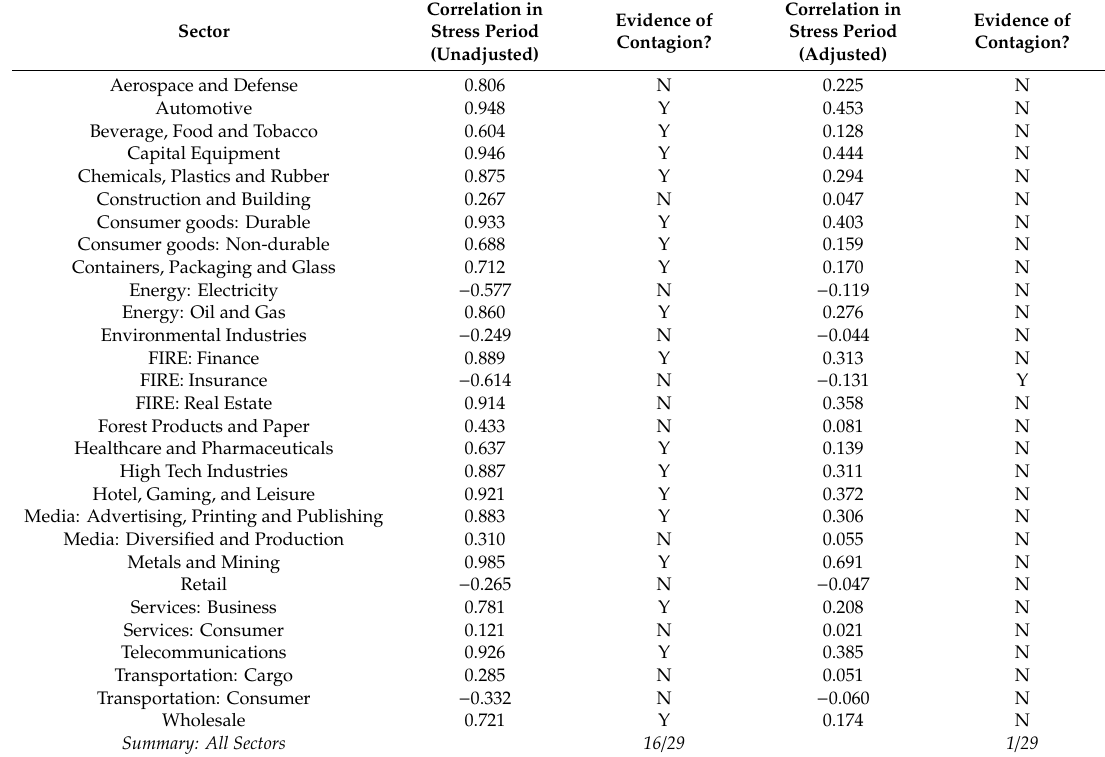
Table 1. Biased and adjusted correlation coefficients for contagion tests in August 2007. Source: Author’s calculations. Note: Contagion tests based on statistical tests for differences in correlation coefficients calculated in “stress period” (defined as January 2008 until January 2011) compared with correlation coefficients calculation between February 2003 and January